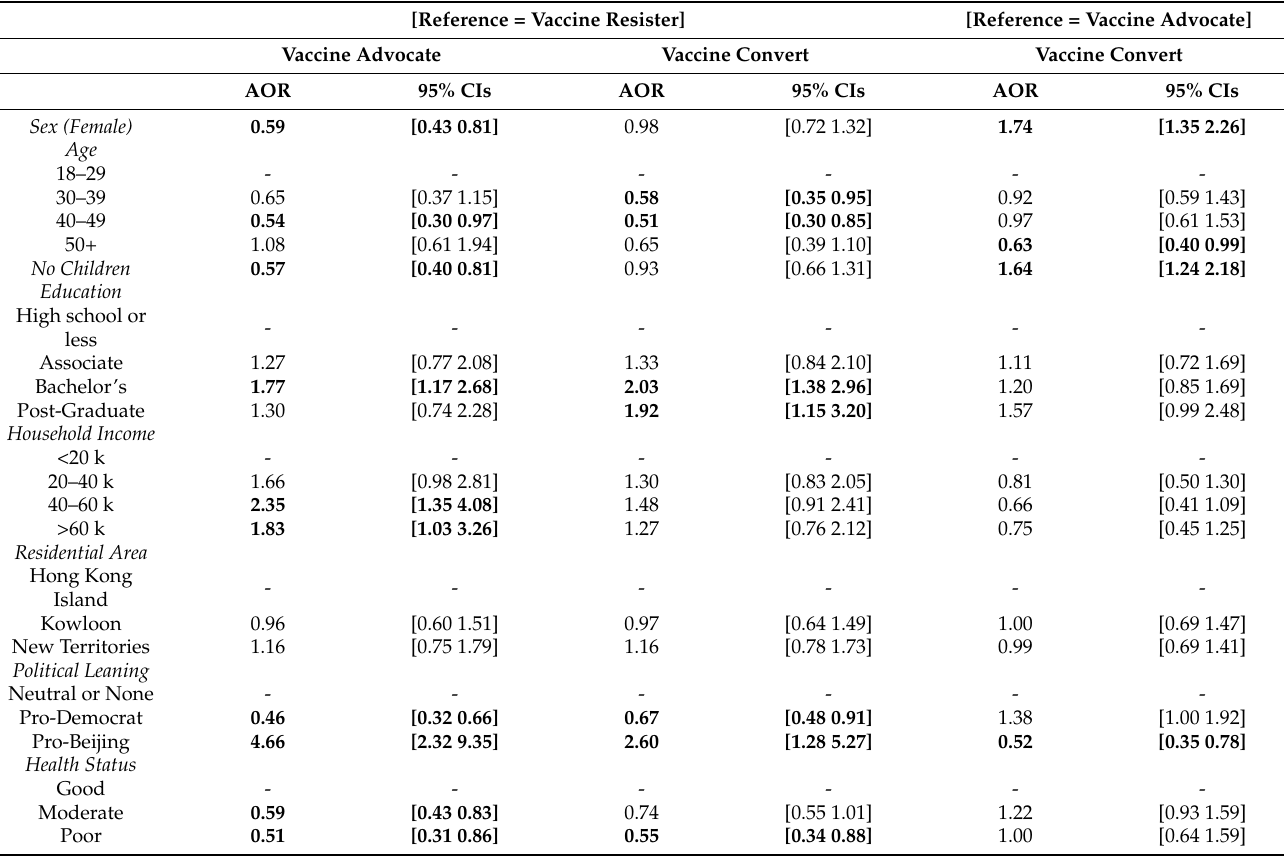
Table 2. Sociodemographic indicators associated with vaccine resisters, advocates, and converts in Hong Kong,